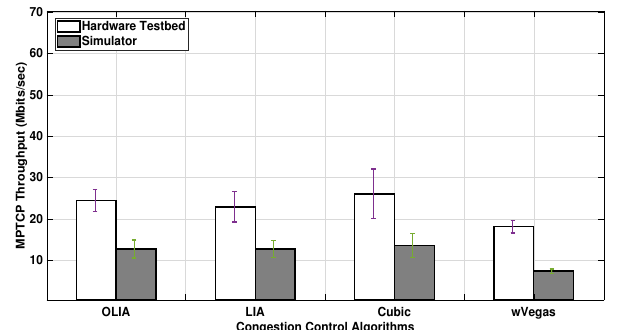
Figure 7. Setup 2 Uplink MPTCP Throughput for 20 MB flows.